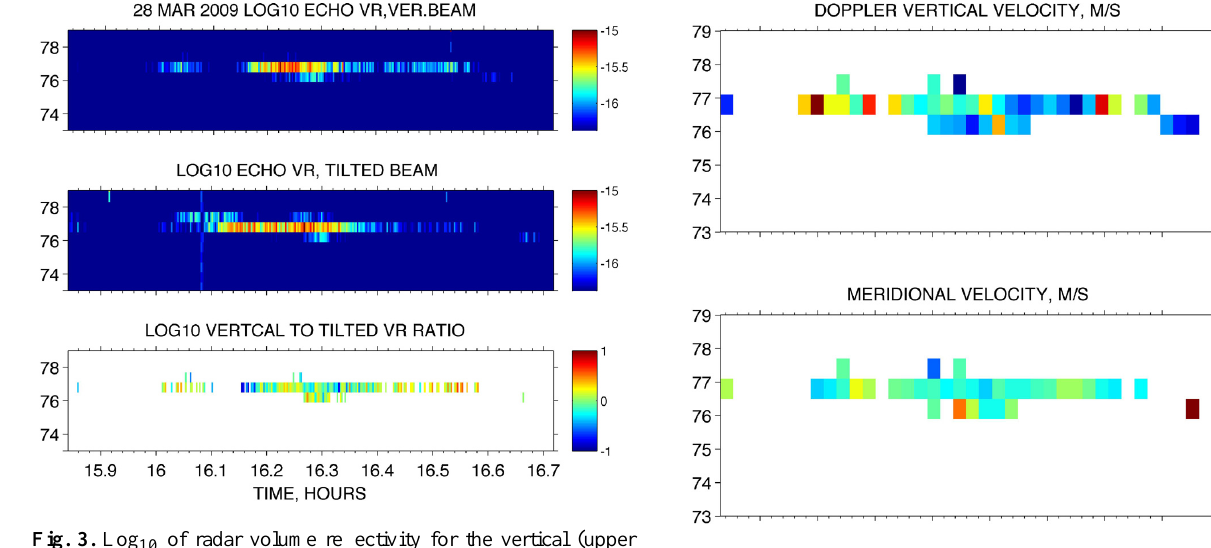
Fig. 3. Log 10 of radar volume reflectivity for the vertical (upper panel) and tilted (middle panel) beam and their ratio (lower panel) with time resolution of 4.1s for the experiment on 28 March 2009. The vertical axis is altitude in km.